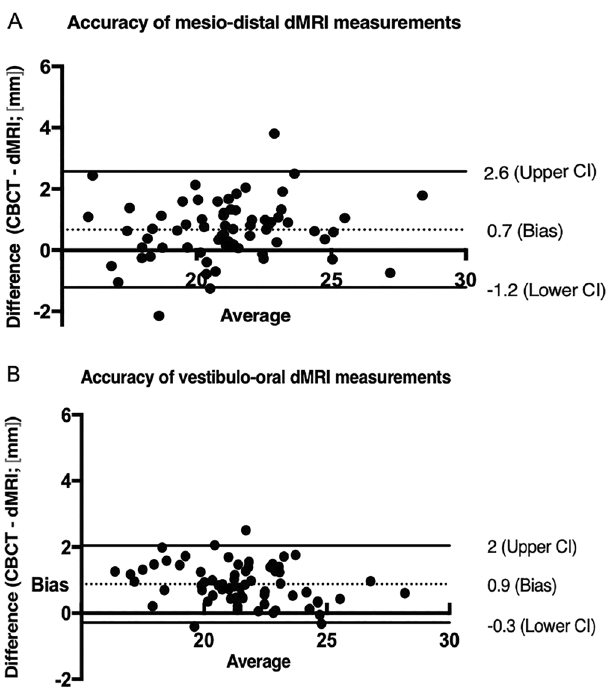
Figure 3. Bland–Altman plots, illustrating differences between corresponding CBCT and dMRI canal length measurements in the mesio-distal ( A ) and vestibulo-oral ( B ) plane. The dotted line represents the mean differences (bias) and the solid lines represent the upper and lower 95% limits of